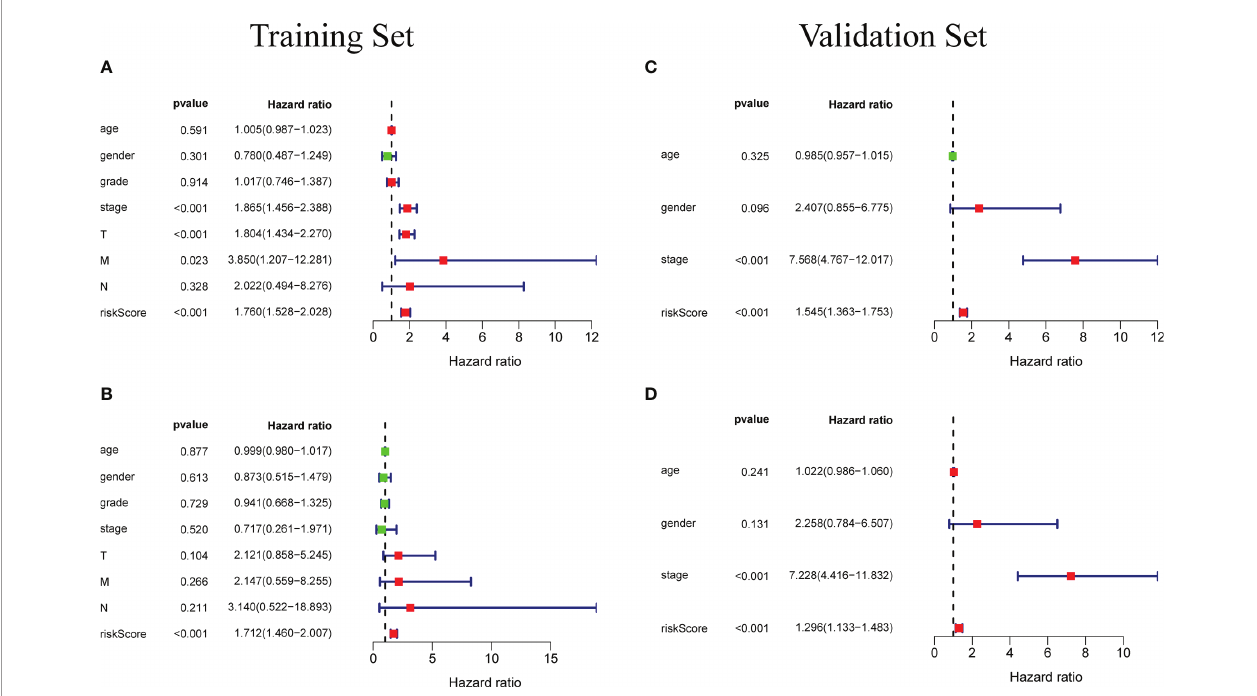
FIGURE 6 | (A) Univariate independent prognostic analysis of the training set. Forest plot of the association between risk factors and overall survival of patients. (B) Multivariate independent prognostic analysis of the training set. The risk score based on the prognostic model can be used as an independent prognostic factor for hepatocellular carcinoma. (C, D) Independent prognostic analysis of univariate and multifactorial factors in the validation set. The forest map shows that the risk score can also be used as an independent prognostic factor for hepatocellular carcinoma in the validation set.